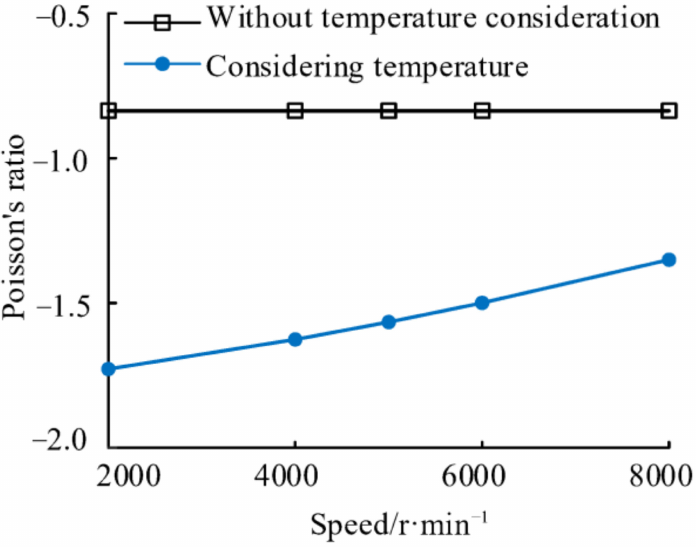
Figure 11. Poisson’s ratio variation of NPR spacer with speed.